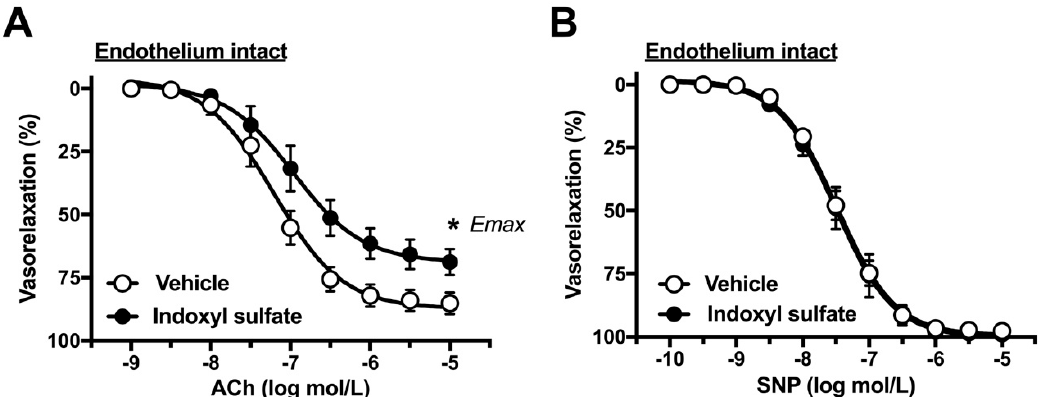
Figure 1. Concentration–response curves for acetylcholine (ACh) ( A ) or sodium nitroprusside (SNP) ( B )-induced vasorelaxations in the aortas in the absence (vehicle) and presence of indoxyl sulfate (10 − 4 mol/L). Ordinate shows vasorelaxation as a percentage of PE-induced vasocontraction (0% being defined as the plateau level of precontraction). Data are presented as mean ± standard error of mean (SEM) values from ten ( A ) or five ( B ) experiments. * p < 0.05, vs. vehicle; E max .